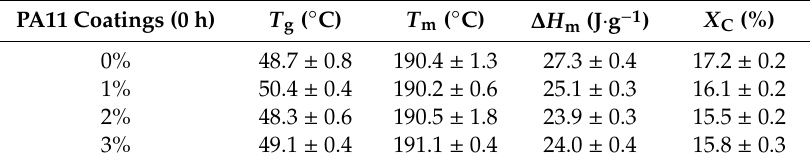
Figure 3. Non-isothermal DSC curves at 0 h and 500 h xenon exposure of 0% and 3% coatings. Table 2. Thermal properties of the organic coatings before xenon exposure.